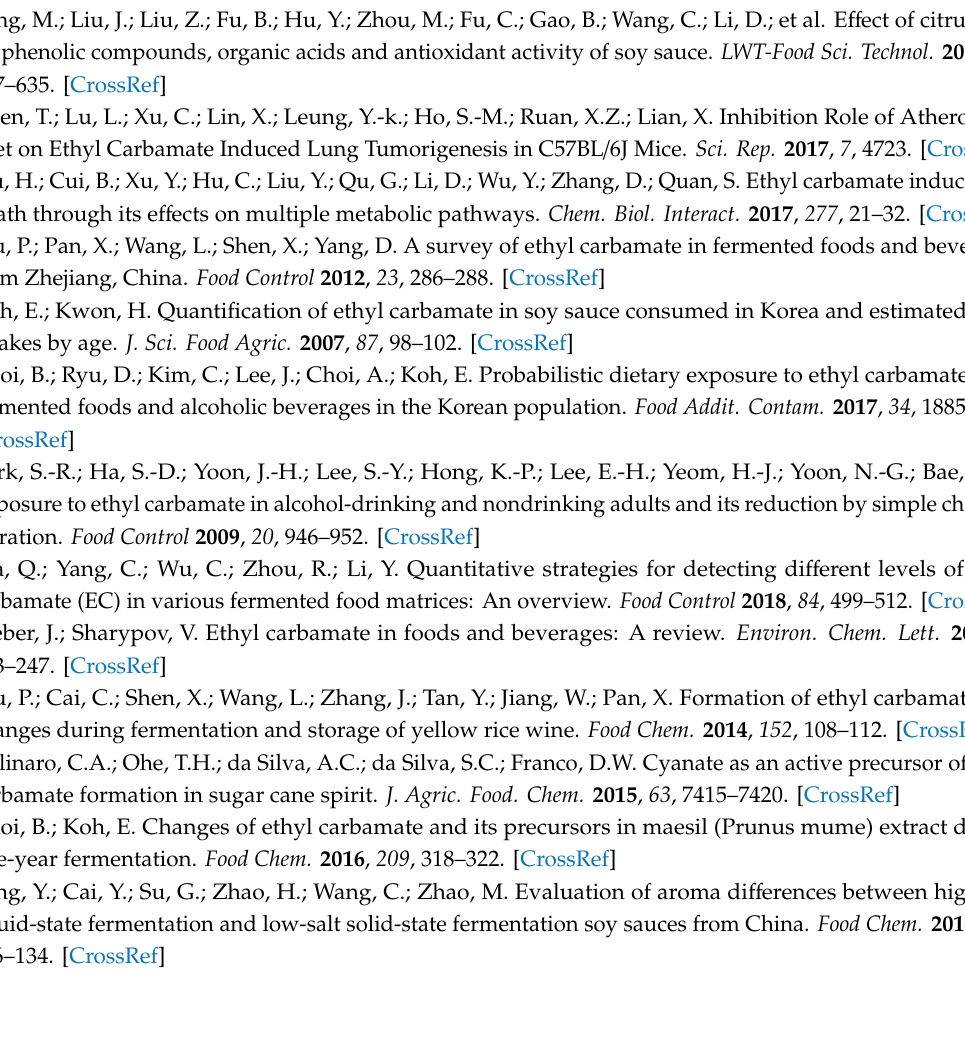
Figure S1: Amino acid chromatogram of standard (a) and soy sauce sample (b), Figure S2: Changes of cyanide in Cantonese soy sauce and soy sauce fermented in the lab, Table S1: Content of Cu, Fe, Ca, Mg in three kinds of fermentation broth, Table S2: Mean value of free amino acid (mg / mL) in three kinds of soy